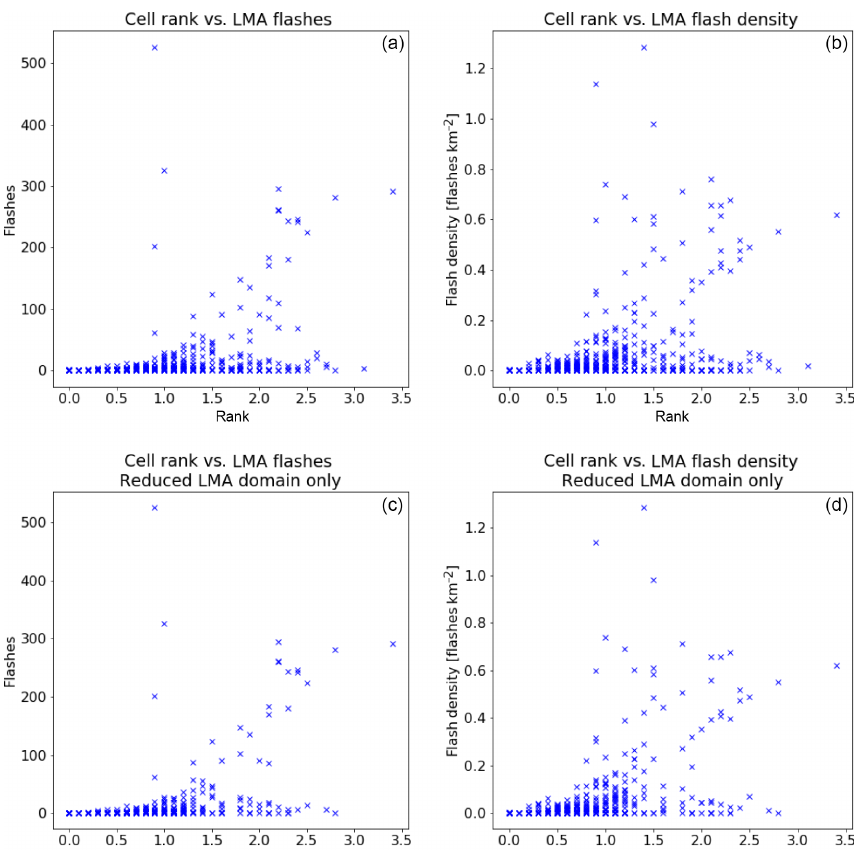
Figure 4. Scatter plot of rank versus (a, c) number of first VHF sources within the TRT cell detected by the LMA network. (b, d) Density with respect to cell area. (a, b) All detections, 1571 points. (c, d) Detections only when centre of TRT cell within reduced domain, 965